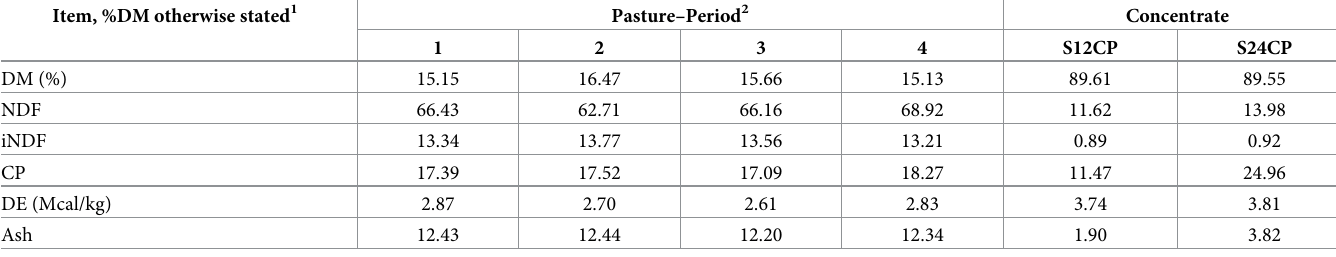
Table 1. Pasture ( Panicum maximum , cv Mombac¸a) and concentrate chemical composition (DM